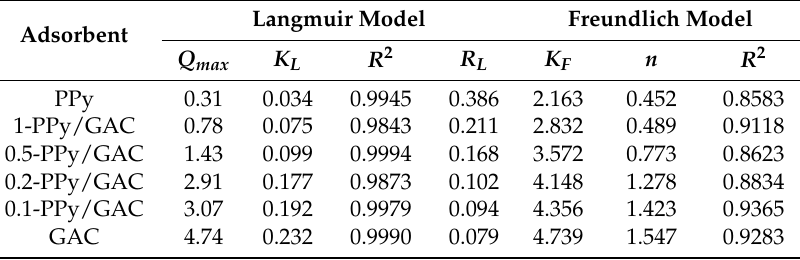
Table 4. Parameters for the Langmuir and Freundlich adsorption isotherm models. Adsorbent